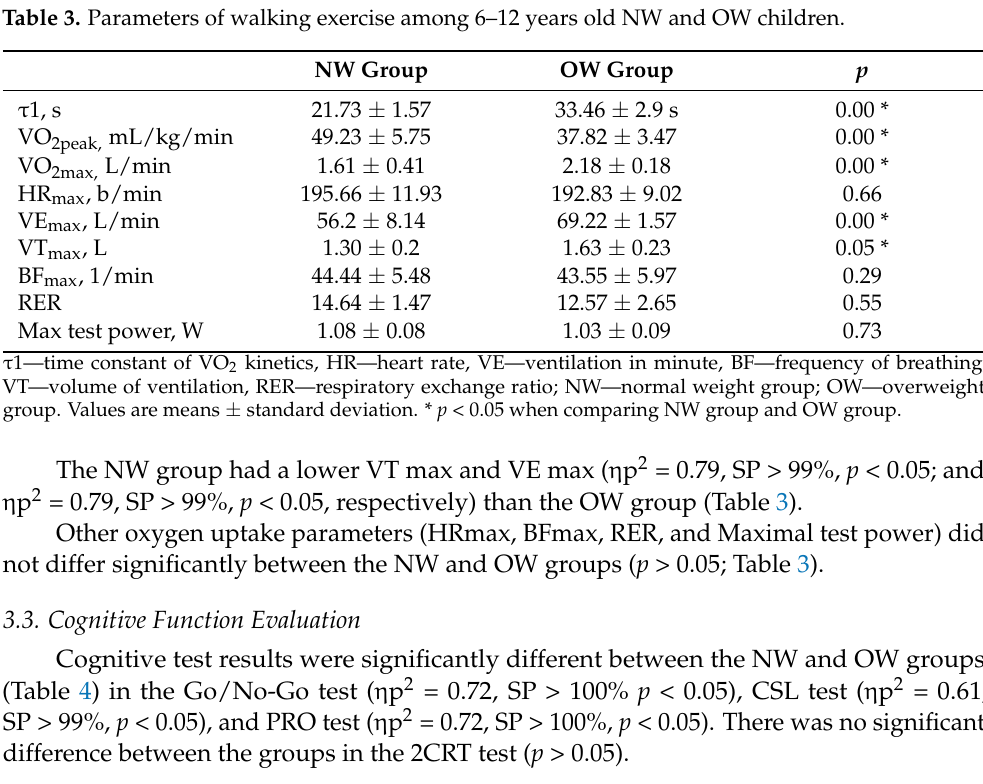
Table 4. Cognitive tests results between NW and OW 6–12 years old children.